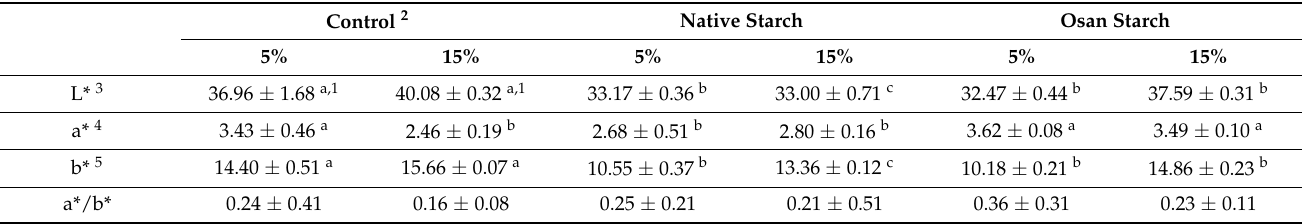
Table 6. The effect of octenyl-succinylated (Osan) corn starch, native starch, and animal fat on the color characteristics of un-cooked meat patties after 6